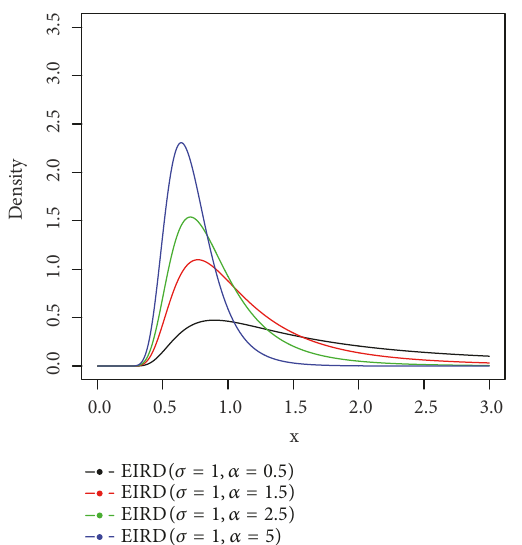
Figure 2: Cumulative density function of EIRD with different shape